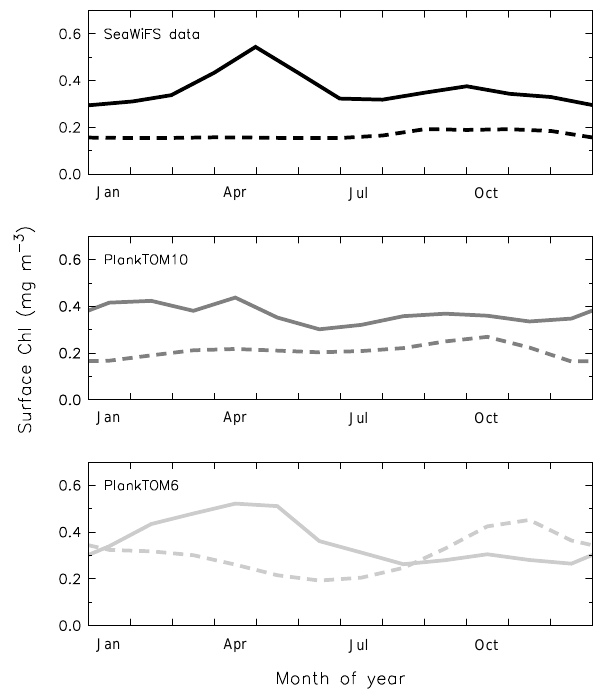
Figure 10. Monthly variations of surface Chl concentration in the North (full solid lines) and South (dashed lines; mgChl m − 3 ) Pa- cific Ocean. Data are from (top) the SeaWiFS satellite, (middle) PlankTOM10, and (bottom) PlankTOM6. All data sets are averages for 1998–2009. Model results are shown for the top 10m deep sur- face box. All data are averaged between 30 and 55 ◦ latitude in both hemispheres: 140–240 ◦ E in the north and 140–290 ◦ E in the south, as highlighted in Fig.